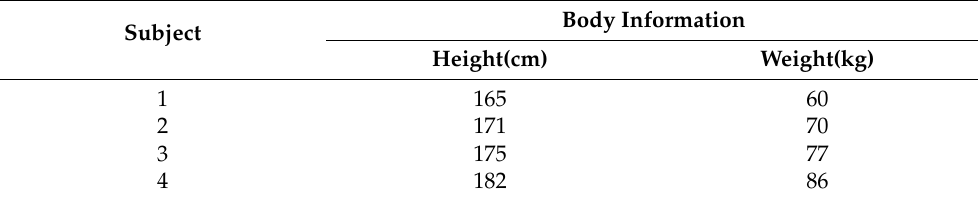
Table 5. Subjects’ physical information.